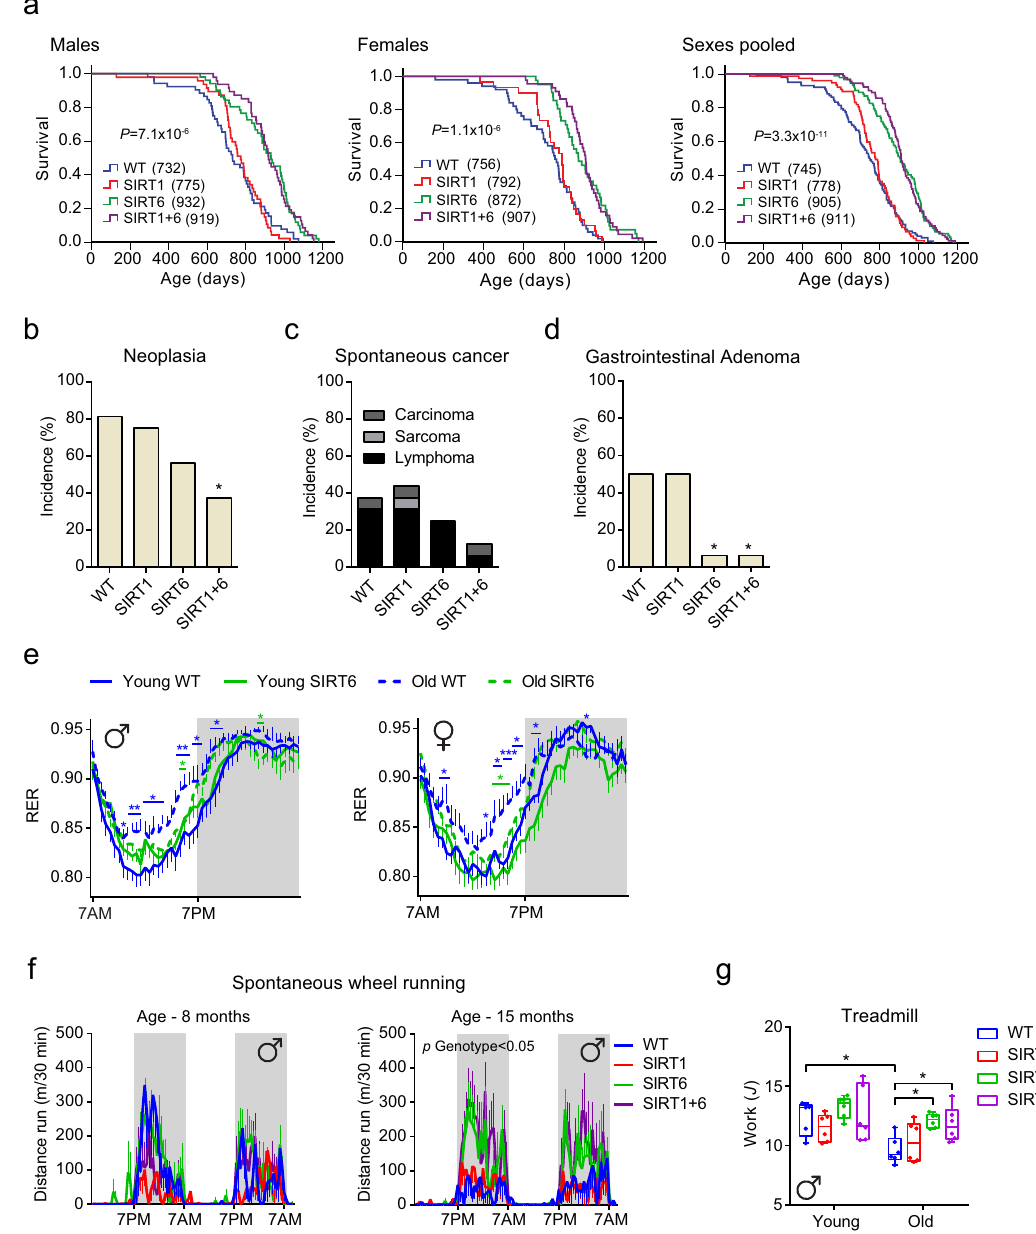
Fig. 1 SIRT6 regulates lifespan and healthspan of C57BL/6JOlaHsd mice of both sexes. a Kaplan – Meier survival curves for male, female, and combined sexes of WT ( n = 52 males, n = 50 females), SIRT1-tg ( n = 47 males, n = 30 females), SIRT6-tg ( n = 51 males, n = 41 females), and SIRT1 + 6-tg ( n = 47 males, n = 44 females) mice. p -values for SIRT6-tg vs. WT mice are shown and were derived from two-tailed log-rank calculations. Median lifespan for each genotype is shown in parentheses. b – d Neoplasia ( b ), cancer ( c ), and gastrointestinal adenoma ( d ) incidence at the age of 25 months. For ( b – d ), n = 16 mice per genotype, a mixture of both sexes. Two-tailed Fisher ’ s exact test; * p < 0.05 vs. WT. Exact p -values are reported in Supplementary Table 1. e Respiratory exchange ratio (RER) averaged over 3 days in young and old WT and SIRT6-tg mice from either sex measured every half-hour. Three-way ANOVA with repeated measures with age, genotype, and time as variables. Sidak ’ s post hoc; young WT (* in blue) or old SIRT6 (* in green) vs. old WT. n = 8 mice per group, except for young SIRT6 where n = 7 mice. f Spontaneous wheel running activity of males at the ages of 8 months ( n = 8 mice per genotype) and 15 months ( n = 9 mice for WT, SIRT1, SIRT6, n = 7 mice for SIRT1 + 6). Two-way ANOVA with time and genotype as variables. g Exercise ability on treadmill in young and old males. Two-way ANOVA with Sidak ’ s post hoc. n = 6 mice per group, except for young WT where n = 5 mice. * p < 0.05, ** p < 0.01, *** p < 0.001. In ( e ) and ( f ), values are shown as mean ± SEM. In ( g ), box extends from the 25th to 75th percentiles, line in the middle of the box is the median and whiskers go down to the smallest value and up to the largest. For ( e – g ), exact p -values are reported in the Source Data fi